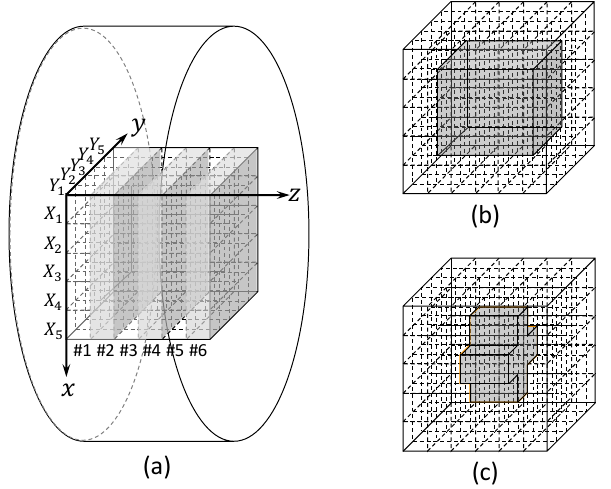
Figure 5. Thick rubber sample for detailed analysis in this study. ( a ) Coordinate axes and sliced areas (#1~#6) in the sample, ( b ) the “around the center” (36 points) and its surroundings (“edge,” 114 points), and ( c ) the center (10 points) and its surroundings (“edge,” 140 points).